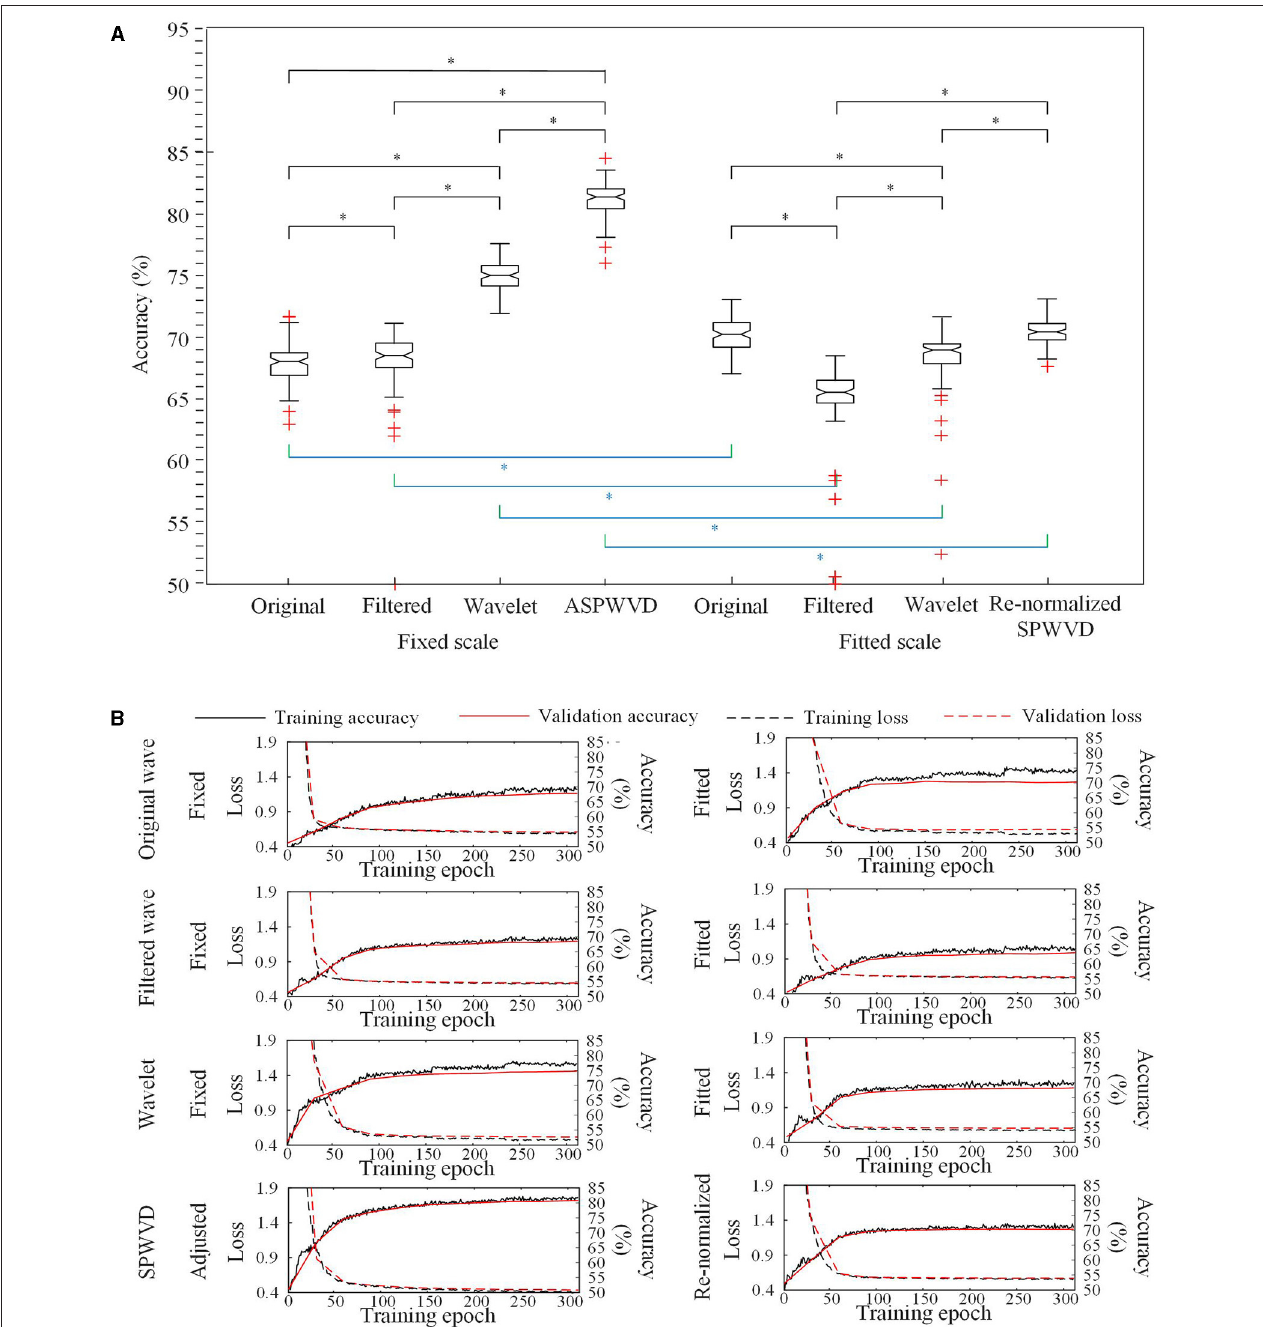
FIGURE 7 | Convolutional neural networks (CNN) accuracies for ripples classification. (A) Accuracies of CNNs for ripples classification using various transformations. The CNN network using the fixed-scale ASPWVD images provides the highest accuracy ( p < 0.05). Except for original ripple waveforms, the results from CNN models that are trained using fixed-scale images are significantly better than those from models trained using fitted-scale images ( p < 0.05). (B) CNN training and validation accuracies and losses are displayed. Asterisk (*) means a statistically significant difference.